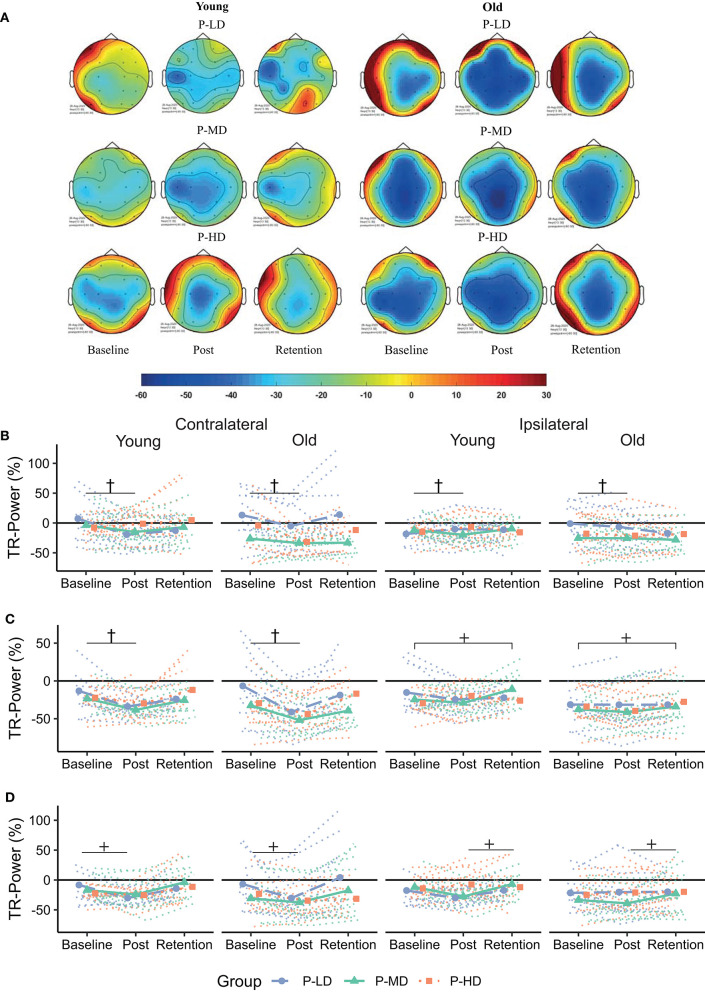
(A) Topographical plots showing the distribution of beta TR-Power over the ROIs for the different age and practice groups. Cooler colors represent lower TR-Power (i.e., higher activity). Black dots represent the electrodes used to define the ROIs. (B–D) Change in TR-Power over time for the frontal (B), motor (C), and parietal (D) cortex. Dotted lines represent individual trajectories. Overall, there was a decrease in beta TR-Power from baseline to the post-test. This decrease was specific for participants who practiced at the low or medium difficulty levels over the frontal and motor cortices and lateralized to the contralateral hemisphere over the motor and parietal cortices. P-LD, Practice with Low Difficulty (blue dots); P-MD, Practice with Medium Difficulty (green triangles), P-HD, Practice with High Difficulty (orange squares). †Time*Practice group interaction at p < 0.05; +Time*Hemsphere interaction at p < 0.05.